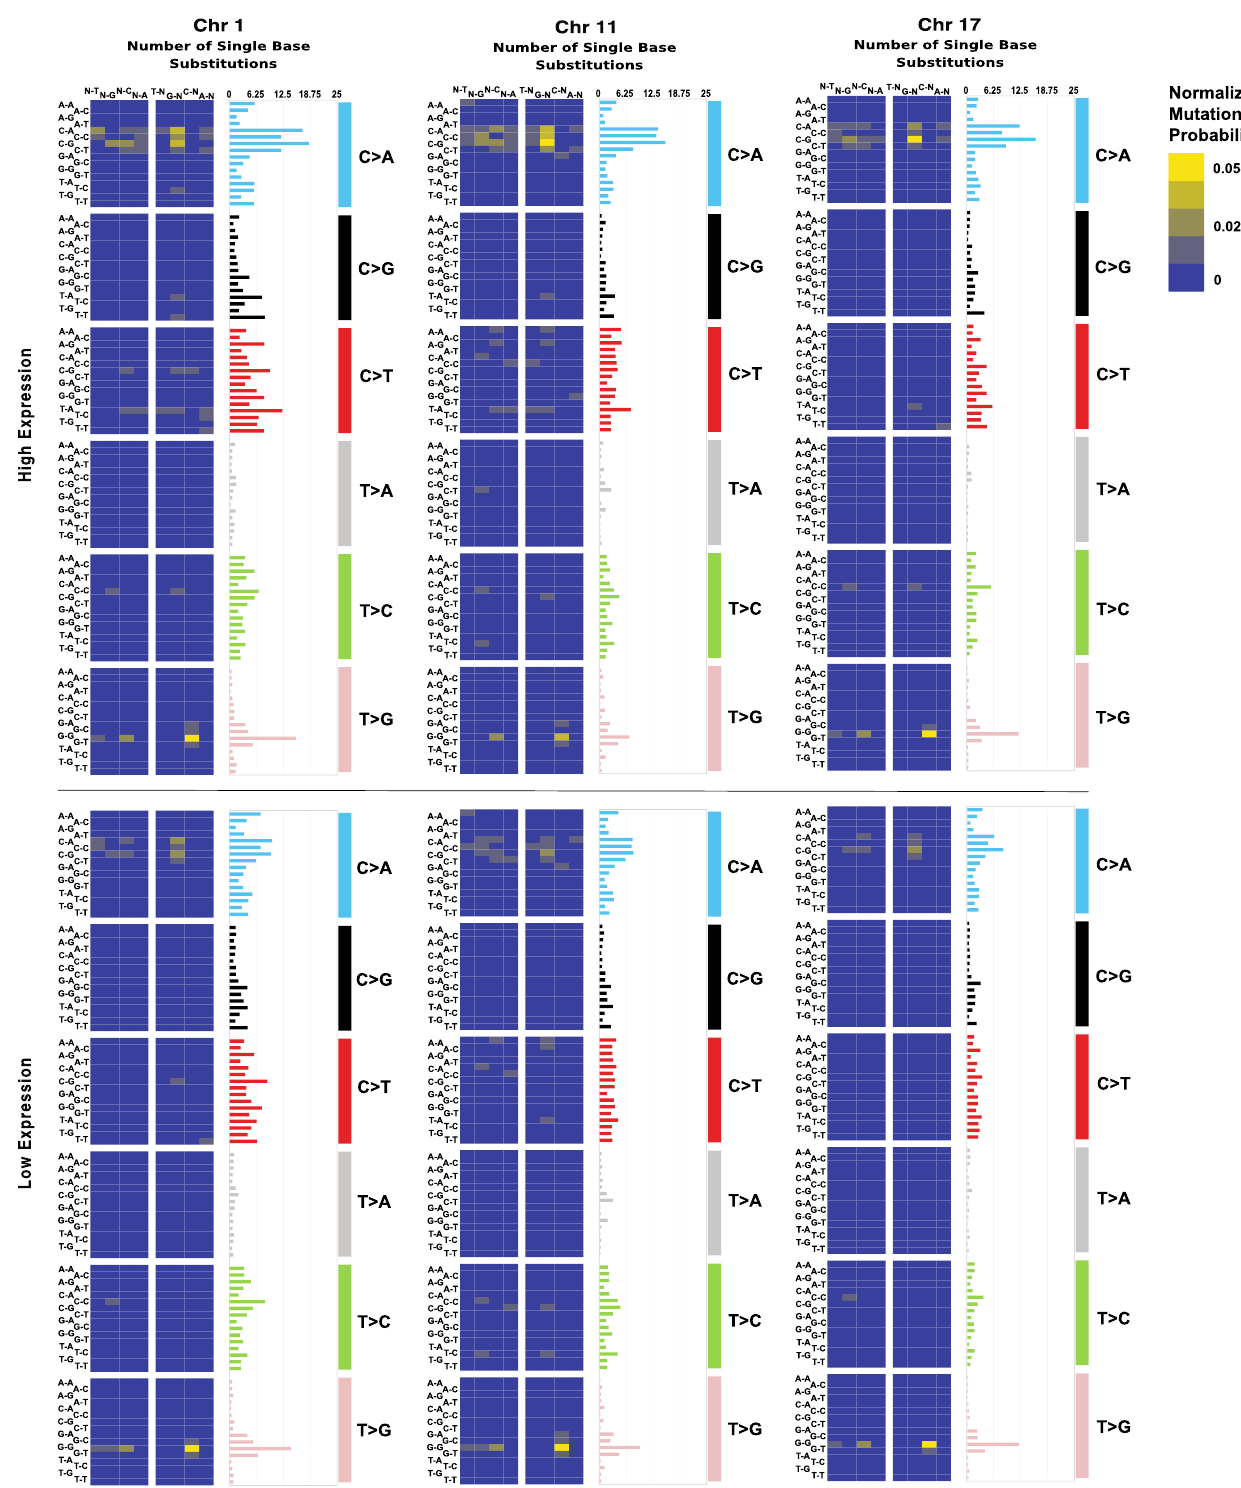
Figure 2. Single base substitution distribution of chromosomes 1, 11, and 17. Bar plots of the average number of point substitutions across samples by E6/E7 high expression and low expression. Heatmaps of the distribution of point mutations by nucleotide type. Patients were categorized by E6/E7 joint-transcripts per million ( TPM ), with TPM ≥ 20 considered high expression, and TPM < 20 low expression.